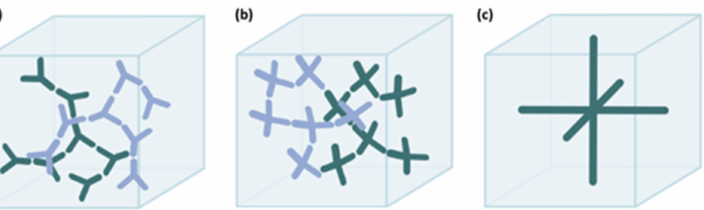
Figure 5. Skeletal graphs of the water channels in the three bicontinuous cubic phases morphologies. ( a ) Ia3d (G-surface), ( b ) Pn3m (D-surface), ( c ) Im3m (P-surface). Adapted from Squires et al., 2006 [40].